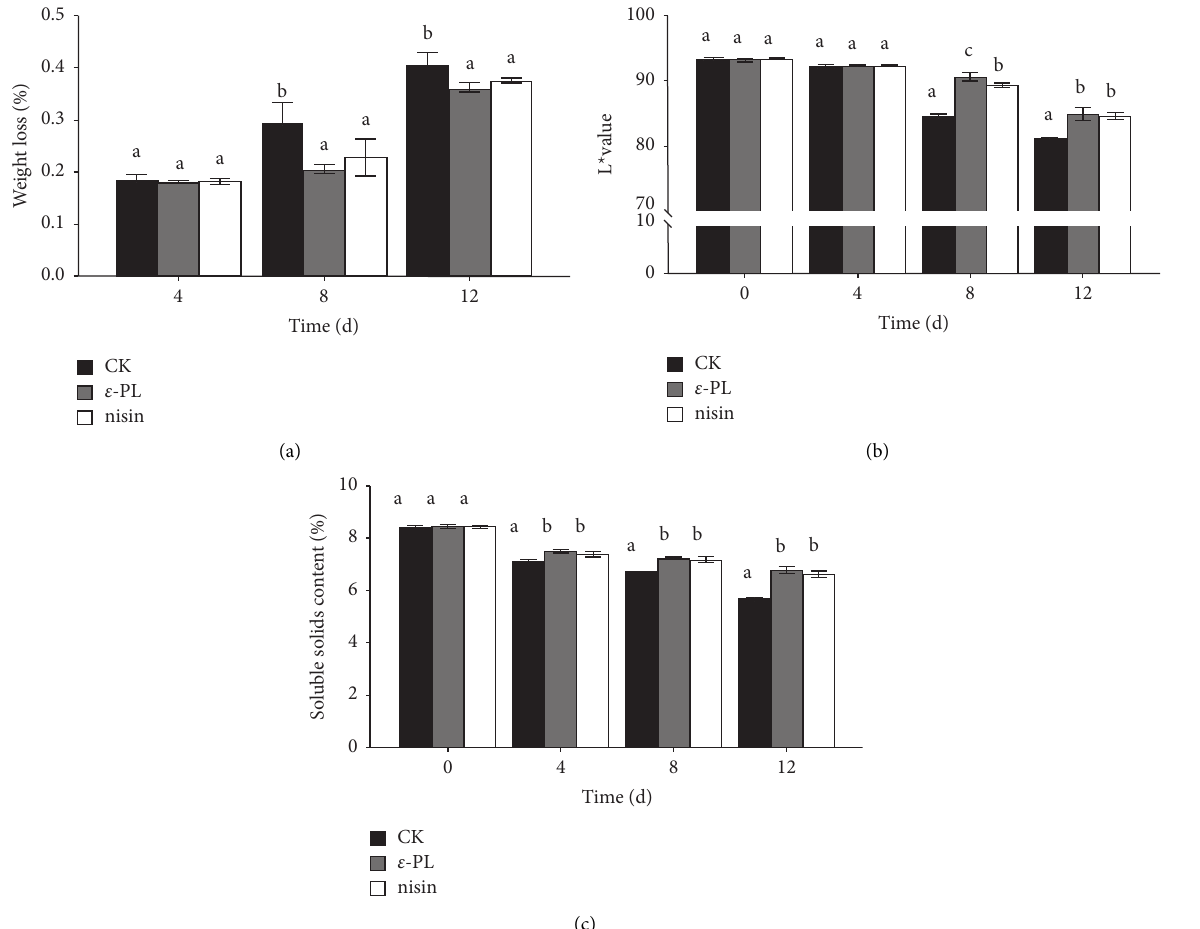
Figure 5: Changes of weight loss, color, and soluble solid content in FVFB. CK: FVFB treated with PBS; ε -PL: FVFB treated with 0.30 g/kg ε -PL; Nisin: FVFB treated with 0.20g/kg